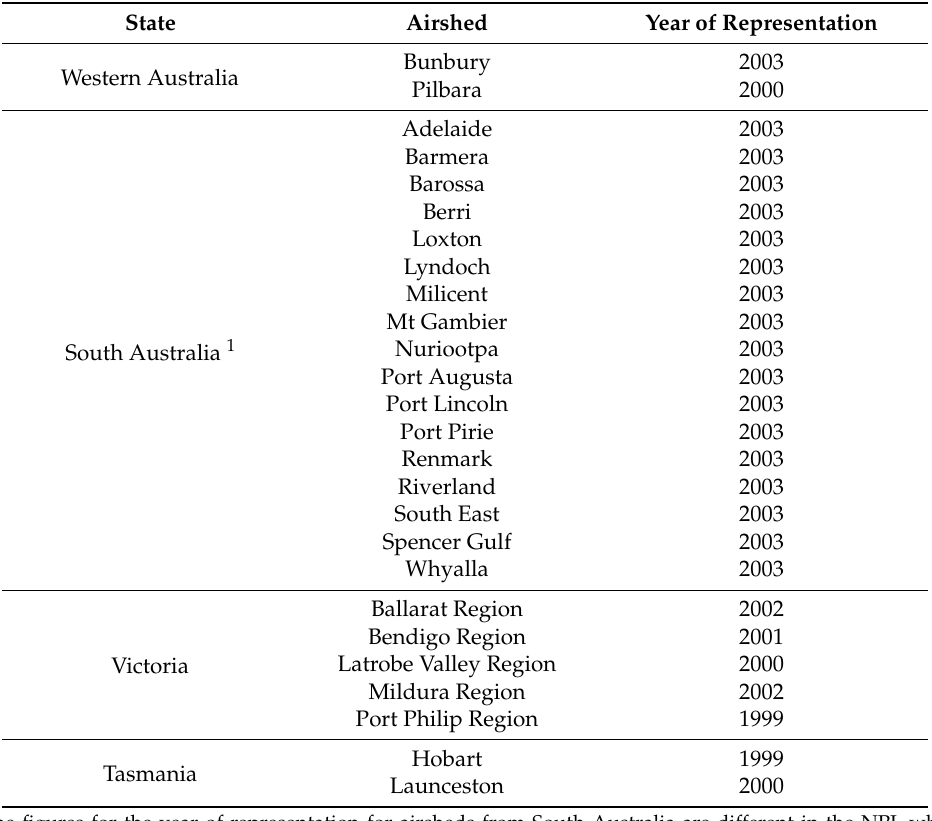
Table 2. Year of representation for current NPI estimates of paved/unpaved roads